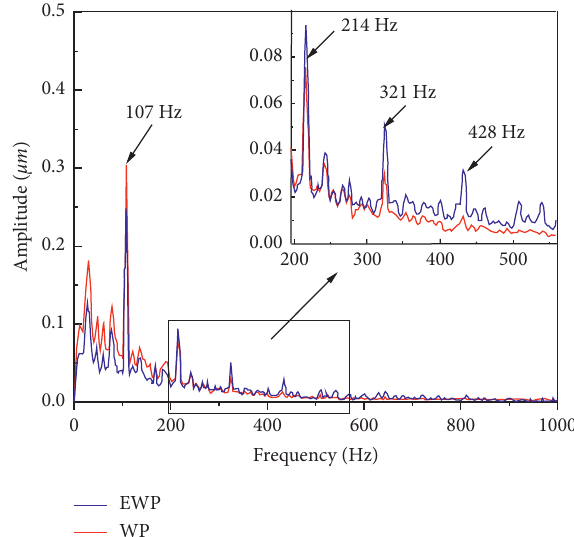
Figure 11: Comparison of core fault signal envelope spectrum of EWP and